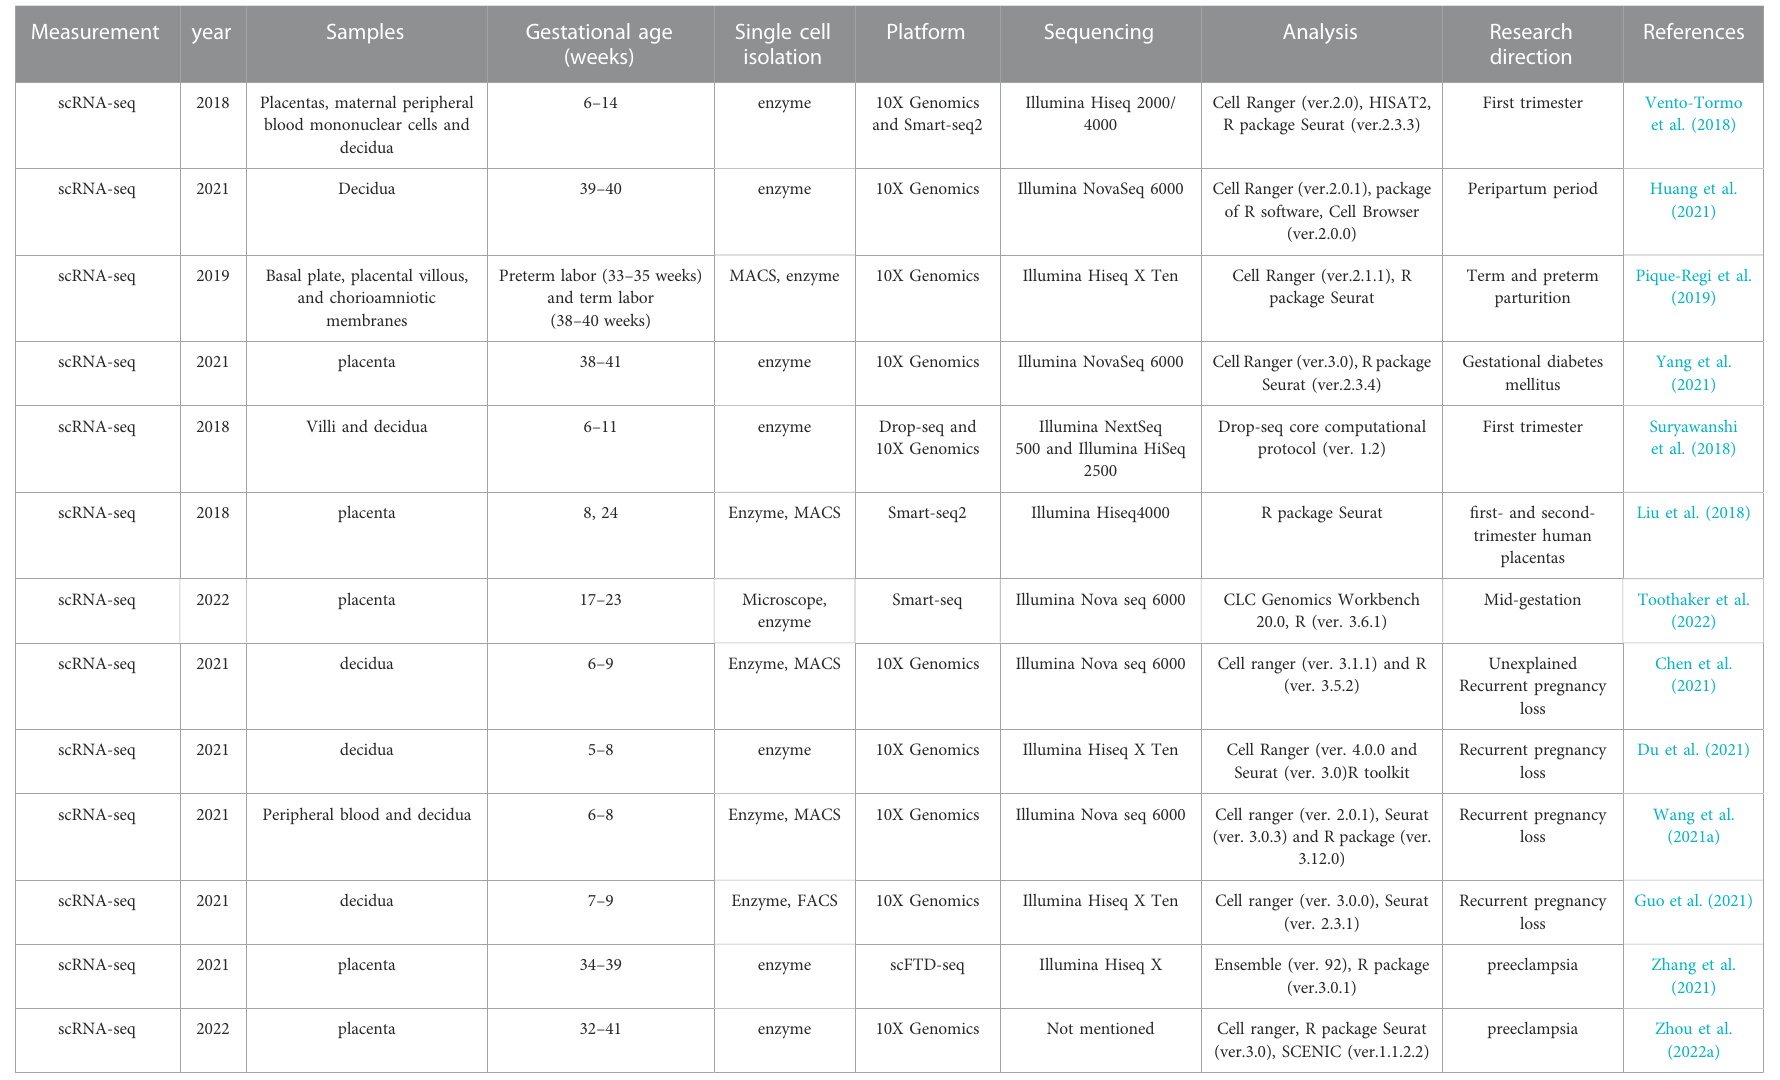
TABLE 1 Summary of current scRNA-seq studies on maternal-fetal